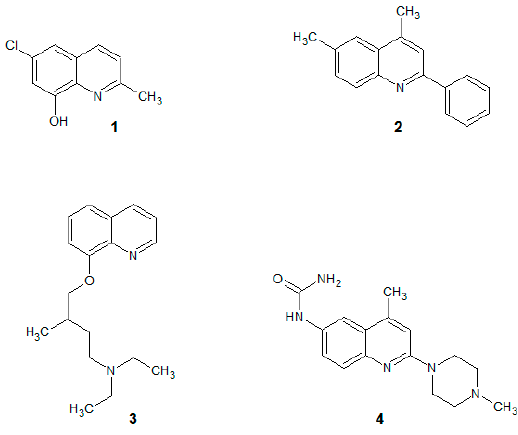
Figure 1. Antifungal quinolines. ( 1 ): oxine derivative; ( 2 ): 2-phenylquinoline; ( 3 ): alkylated oxine; ( 4 ): 2-morpholine derivative.